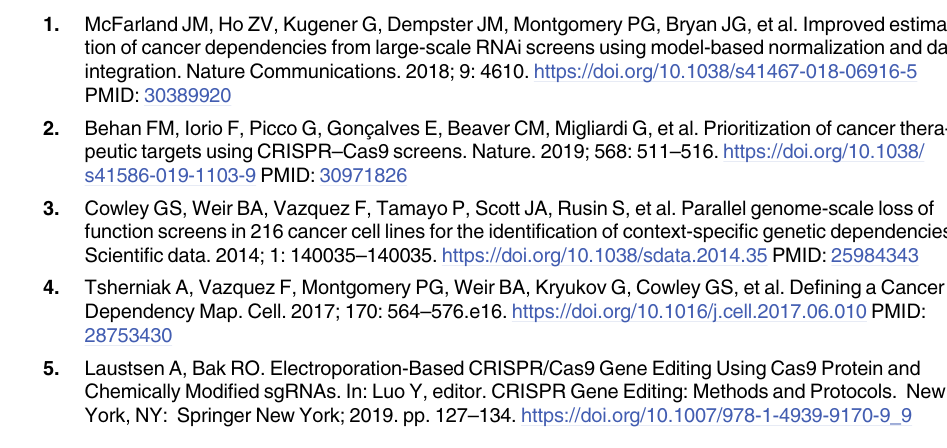
S2 Table. The full list of clusters of kinases that have similar drug binding profiles for the BeatAML dataset. S3 Table. The full list of clusters of kinases that have similar drug binding profiles for the EMBL2016 dataset. S4 Table. Inferred protein dependence values for the GDSC dataset. S5 Table. Inferred protein dependence values for the BeatAML dataset. S6 Table. Inferred protein dependence values for the EMBL2016 dataset. S7 Table. Compounds used in the drug screen datasets included in our